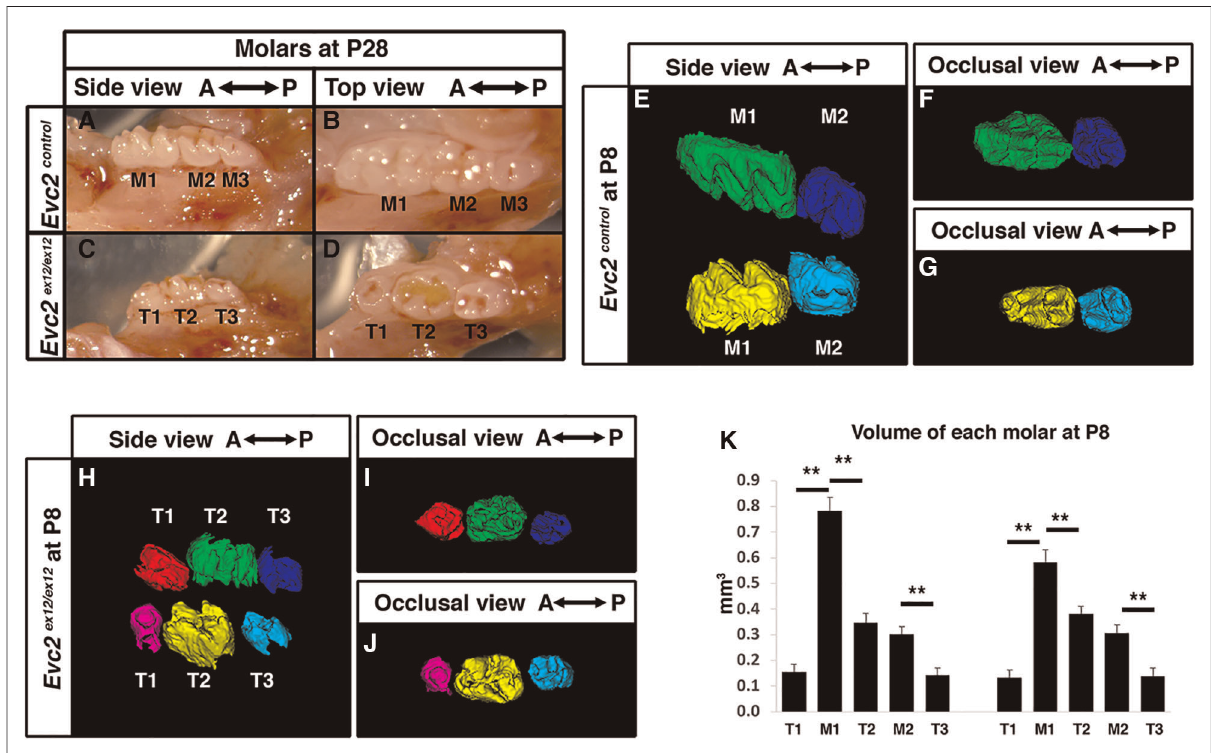
FIGURE 1 Evc2 mutant mice have abnormal molar morphology. Lateral and occlusal images showing the gross morphology of postnatal day 28 (P28) mandibular molars from control ( A,B ) and Evc2 mutant ( C,D ) mice. Molars from controls are marked as M1, M2, and M3 from anterior to posterior. Molars from Evc2 mutants are marked as T1, T2, and T3 from anterior to posterior. CT-reconstructed molars at postnatal day 8 (P8) from control ( E – G ) and Evc2 mutant ( H – J ) mice. Comparison of control vs. Evc2 mutant molar volumes at P8 ( K ). n =4, for maxilla, M1 vs T1, p <0.01; M1 vs T2, p <0.01; M2 vs T3, p <0.01; for mandible, M1 vs T1, p <0.01; M1 vs T2, p <0.01; M2 vs T3, p